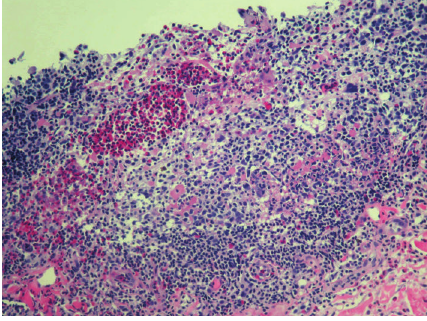
Figure 9: Histology.